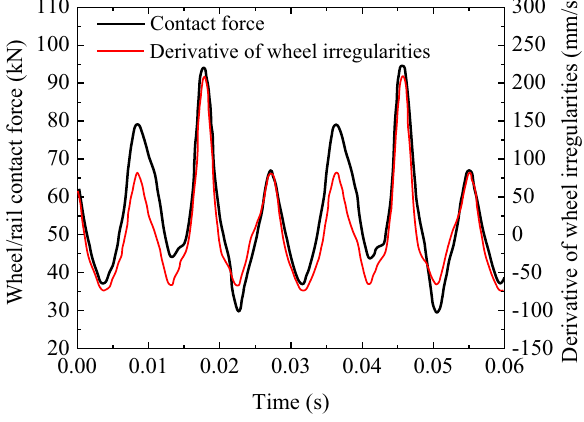
Fig. 6 Time history of wheel–rail contact force and derivative of wheel irregularities at 350 km/h